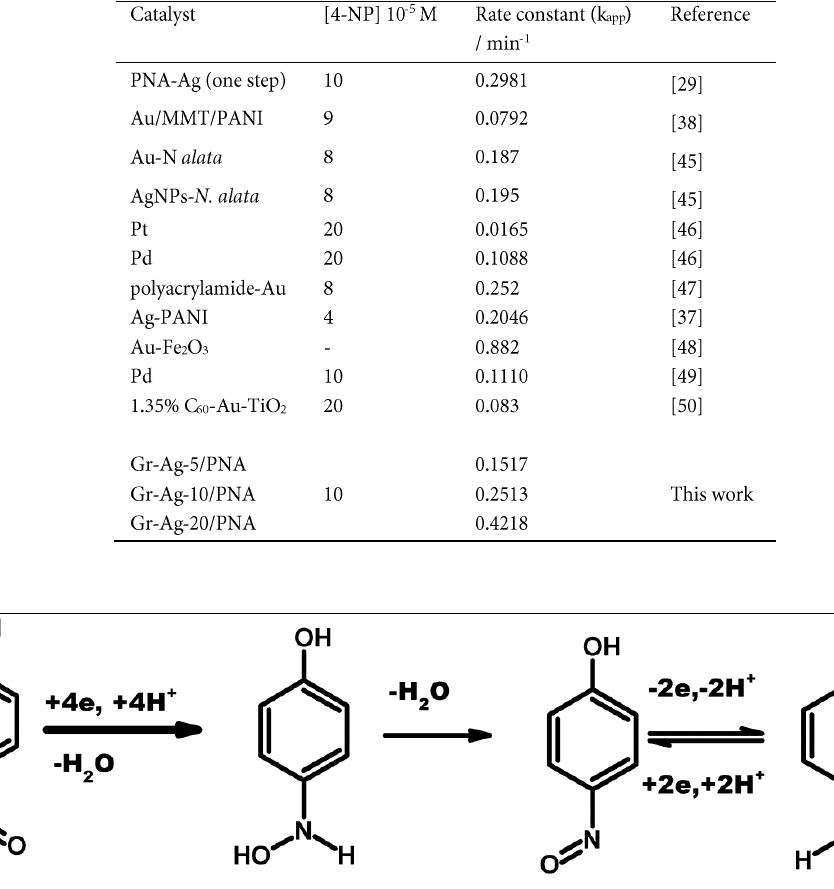
Table.1 Comparison of catalytic performance of Gr-Ag/PNA with some reported catalytic